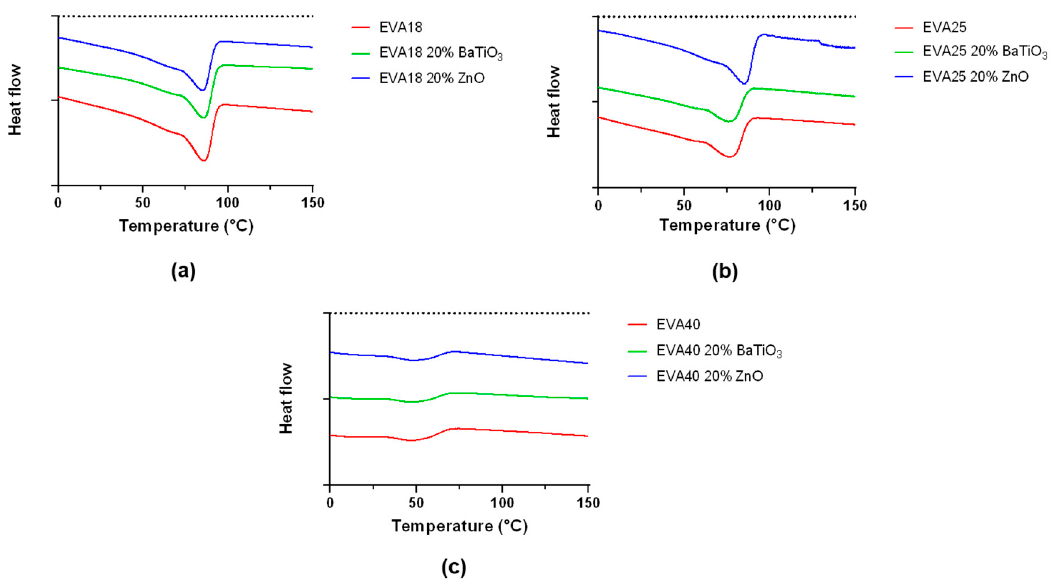
Figure 7. Comparison of the thermograms of ethylene vinyl acetate (EVA) formulations based on: ( a ) EVA18, ( b ) EVA25, ( c ) EVA40.